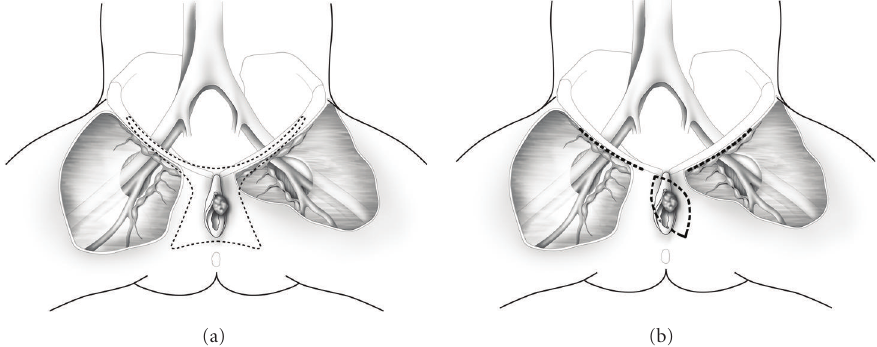
Figure 2: The Bassett-Way operation includes en bloc radical resection of the primary lesion and surrounding vulvar skin as well as the skin over both groins (a). Radical wide excision of the vulvar cancer includes a margin of at least 1 cm of normal skin around the entire lesion. Inguinal lymphadenectomy is performed through separate groin incisions